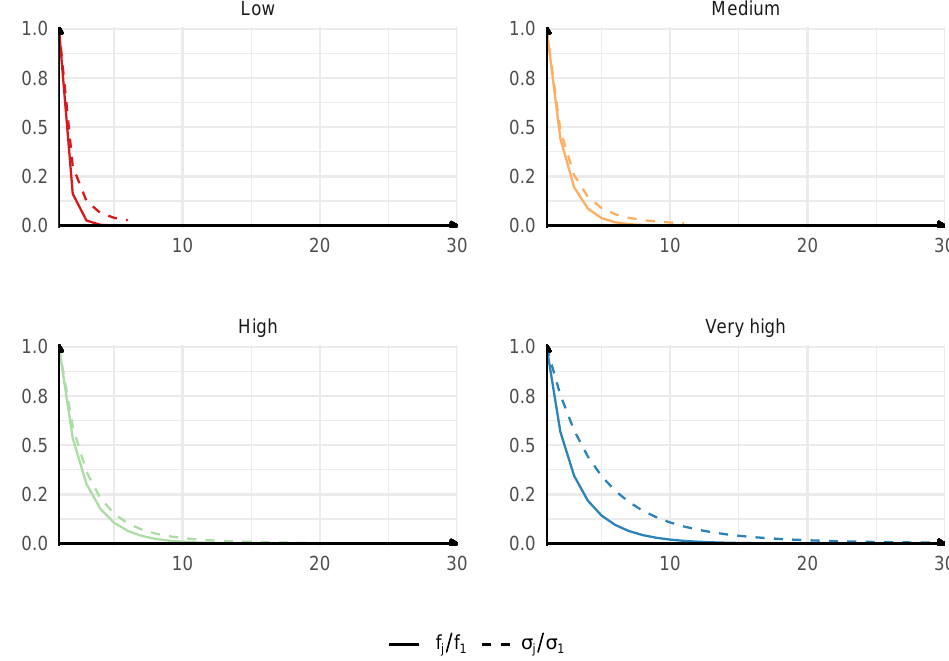
Figure A2. Convergence rates for the parameters f j and σ j .